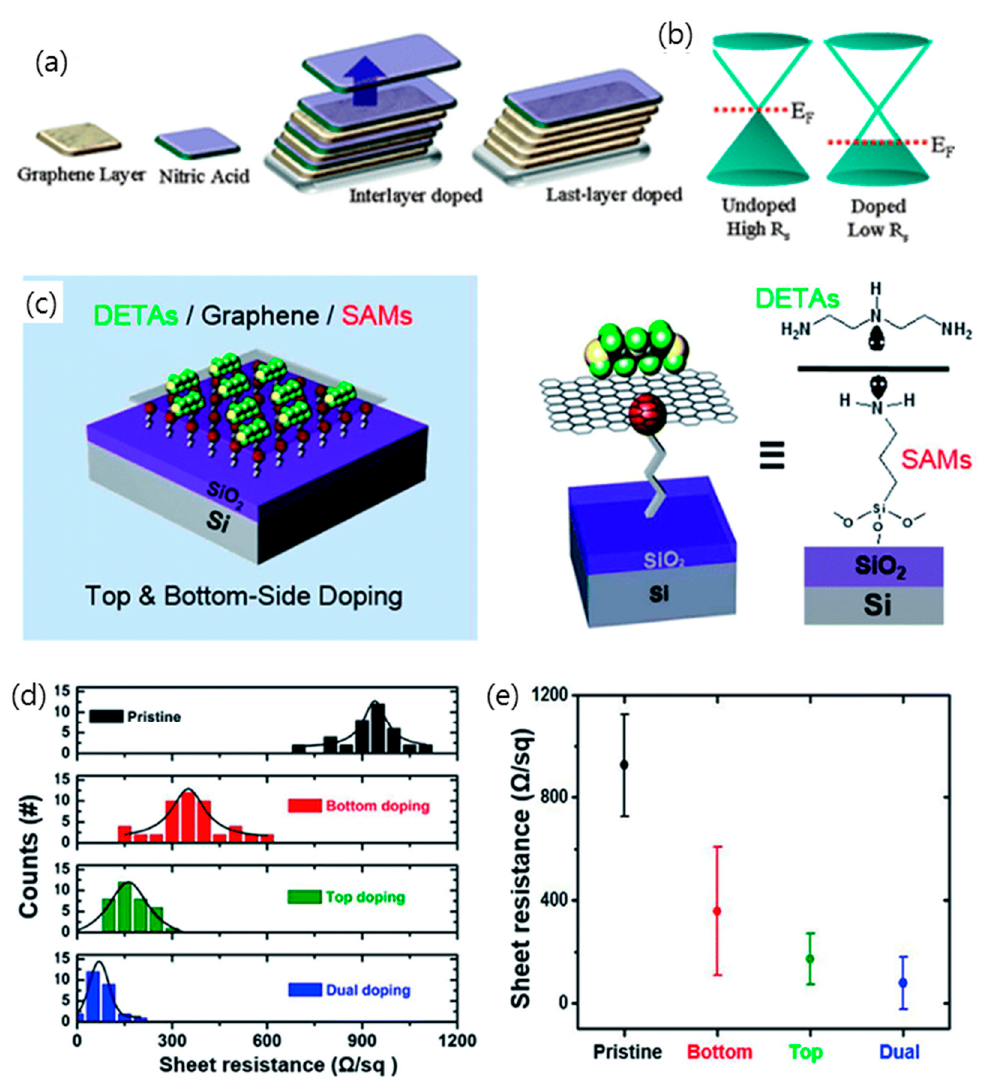
Figure 5. ( a ) Schematic illustrating the interlayer doping methods. The sample is exposed to nitric acid after each layer is stacked. ( b ) Illustration of the graphene band structure, showing the change in the Fermi level due to chemical p-type doping. Reproduced with the permission of Reference [105]. Copyright 2010, American Chemical Society. ( c ) Dual-side doped graphene ( left ) and graphical representation of the molecular structure of the dopants on the both sides of graphene ( right ). ( d ) Histogram of the sheet resistance of graphene doped by NH 2 -SAMs, diethylenetriamine (DETA), and DETA/NH 2 -SAMs (dual-side doped). ( e ) Averages and distributions of the sheet resistance plot of four different types of graphene field-effect transistors (FETs). Reproduced with the permission of Reference [41]. Copyright 2014, Royal Society of Chemistry.